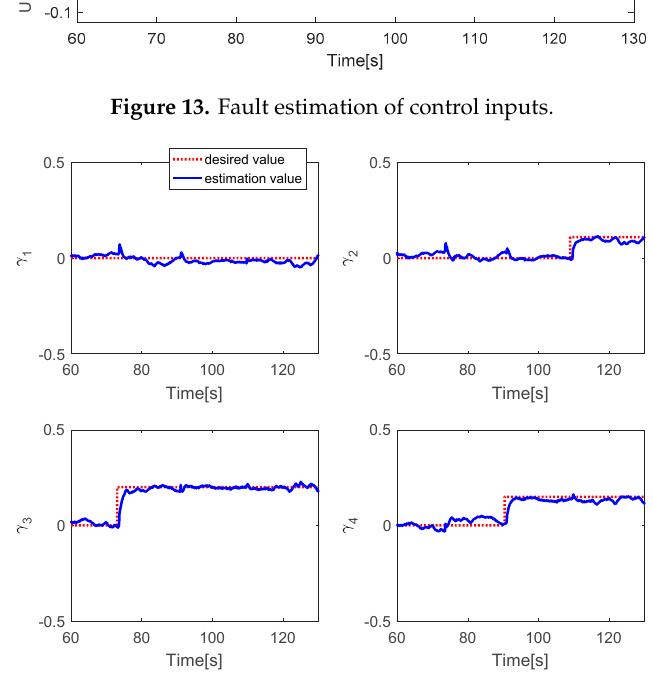
Figure 14. Fault estimation of each actuator.